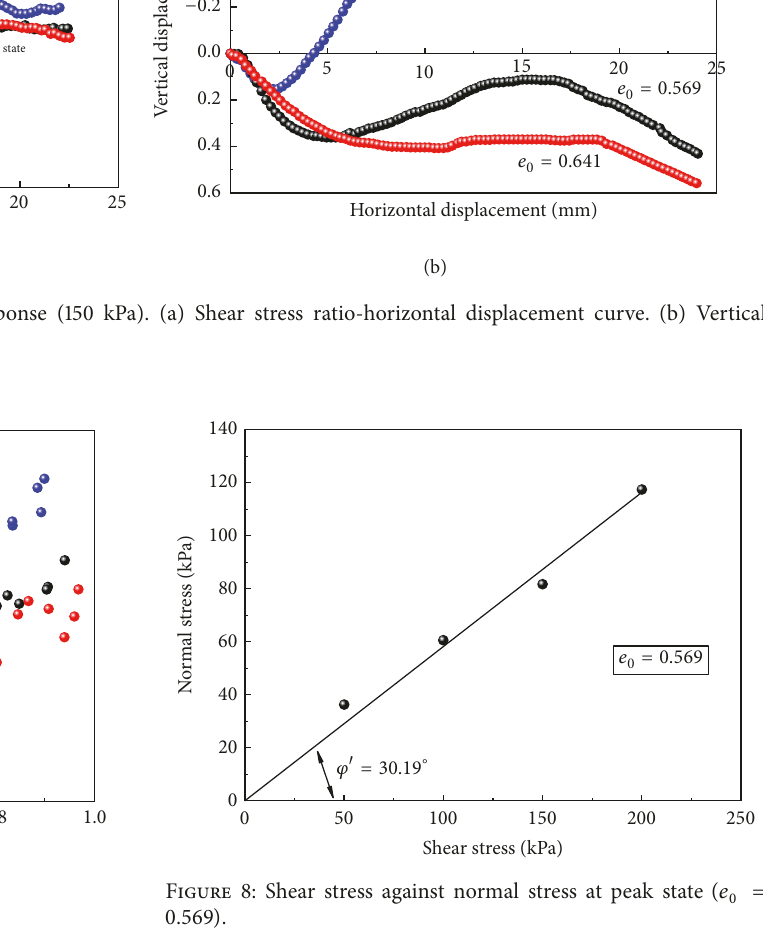
of samples, which indicates denser sample exhibits higher internal friction angle and thus higher shear strength.